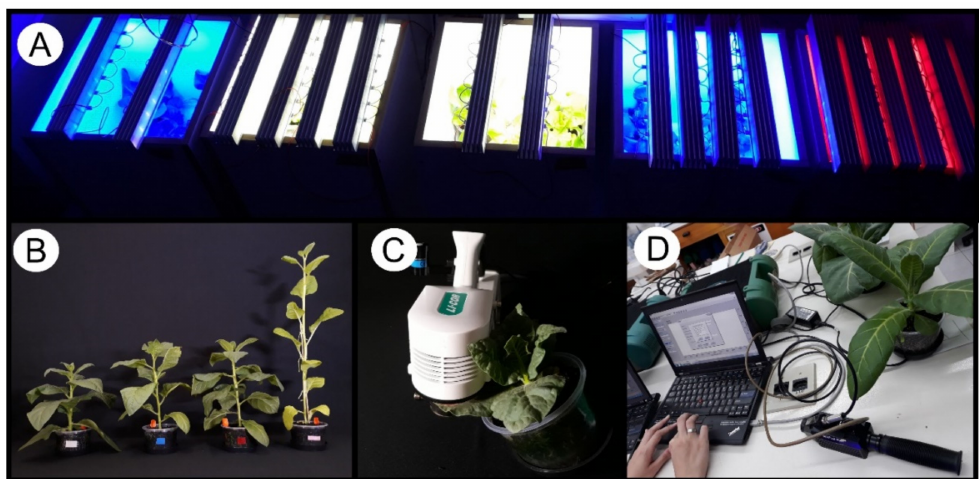
Figure 5. Experimental procedures. ( A ) Box used to grow plants with controlled light quality and intensity. White LED light (W), blue (B), red (R) and red added to far-red (FR); ( B ) random samples of tobacco plants at 35 days old used for sampling. ( C ) “Standard” measuring chlorophyll a fluorescence parameters by infrared gas analyzers (IRGAs; LI-6800, Li-Cor Inc., Lincoln, NE, USA). ( D ) Measuring hyperspectral reflectance by ASD Fieldspec ® (ASD Inc., Boulder, CO, USA).